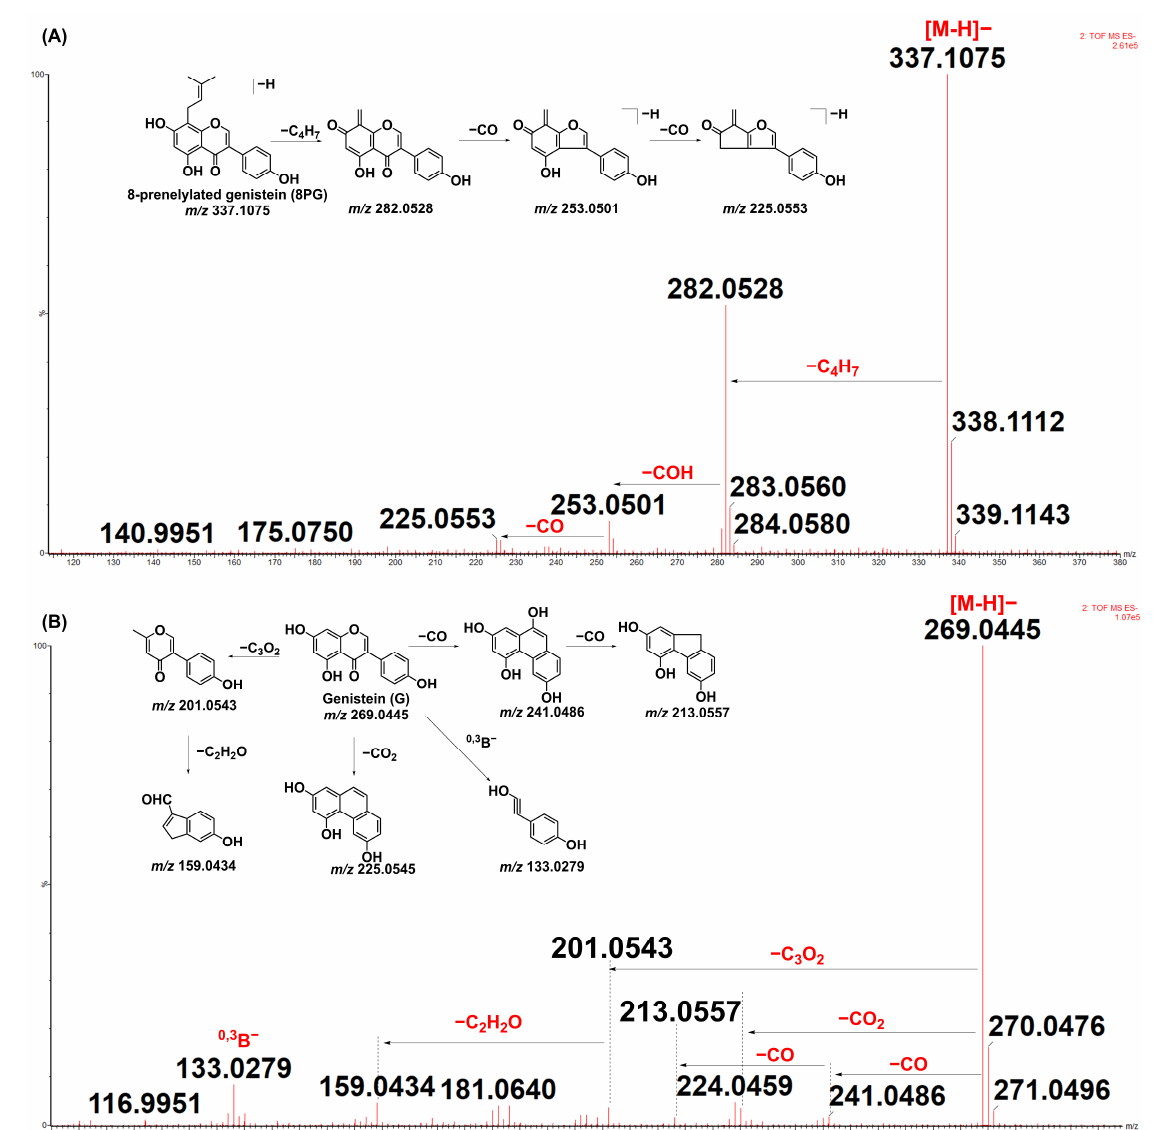
Figure 1. The mass-fragmentation behaviors of 8-prenelylated genistein ( A ) and genistein ( B ). 2.2. Effect of Prenyl Group on the Metabolic Conversion of Isoflavonoids by Gut Bacteria Prenyl-isoflavonoids are the major components in EV [18–21]. To determine whether the prenyl group would alter the metabolic conversion of isoflavonoid through the gut bacteria, the metabolism of the genistein and 8-prenylgenistein (a genistein derivative with the prenyl group at the 8-position naturally present in EV [19]) by the gut microbiota were studied using an in vitro incubation method. The representative ion chromatograms of blank incubated bacterial-culture media, blank incubated bacterial-culture media spiked with genistein, dihydrogenistein, 5-hydroxy equol and 8-prenylgenistein, and the incu- bated genistein and 8-prenyl genistein spiked with rutin (internal standard) are shown in Figure 2A–C. The incubation results showed that the genistein was first metabolized to dihydrogenistein at 8 h and further degraded to 5-hydroxy equol, which reached the highest concentration on the fifth day of incubation (Figure 3A,B). By contrast, no detectable metabolites of 8-prenylgenistein were identified in the incubated bacterial culture media throughout the incubation period (Figure 3A,B). The results suggested that the prenyl group might influence the metabolism of genistein